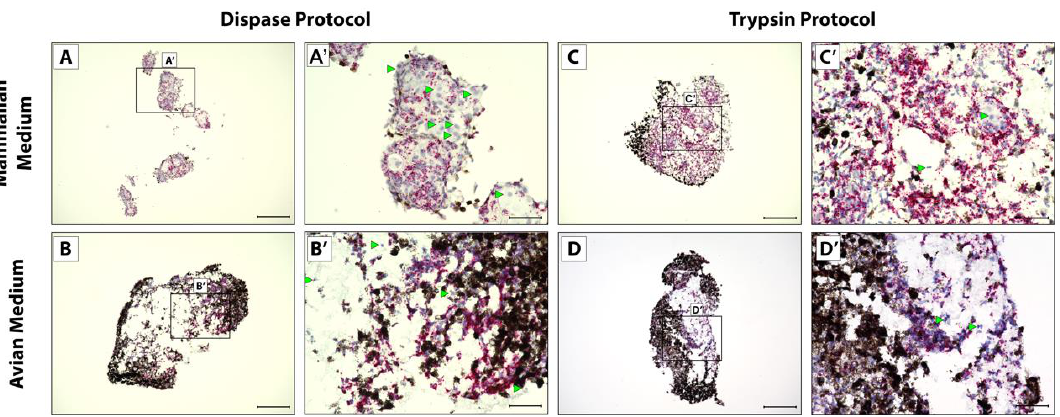
Figure 2. CDH11 expression in micromass blastema organoid cultures. Cell pellets derived